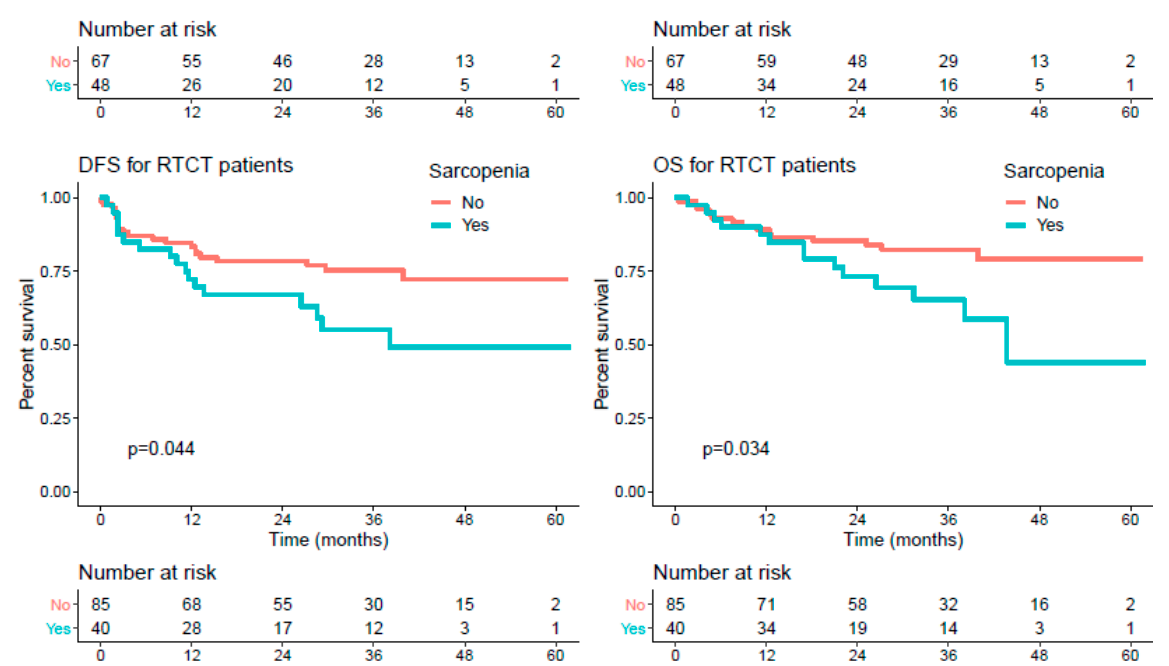
Figure 3. Kaplan–Meier curves of disease-free survival (DFS) and overall survival (OS) for the entire population ( top ) and for patients treated with RT ( middle ) and RTCT ( bottom ).